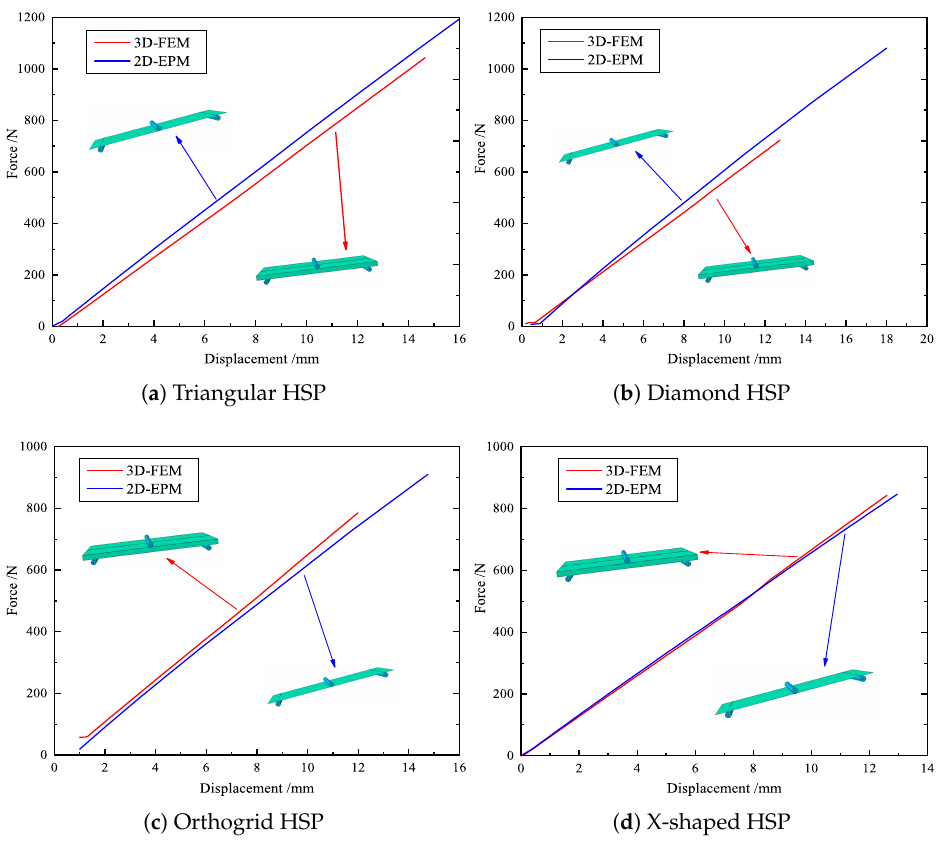
Figure 15. Comparison of displacement–load curves of HSPs with different core forms predicted by different models. Table 9. Comparison of the buckling modes and buckling loads of the diamond HSP under SSSS boundary conditions predicted by different